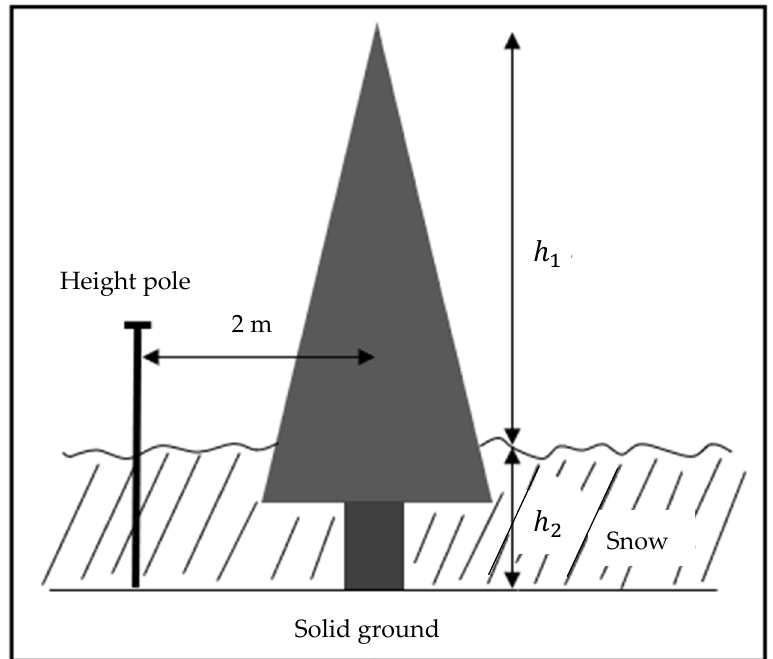
Figure 2. Schematic showing tree height and snow depth measurements. Height h 1 represents tree height measurements above the snow surface measured by a height pole or a vertex clinometer. Height h 2 represents the snow depths measured by a height pole at 2 m distance from the tree stem in the northern, eastern and western cardinal directions. Total tree height was the sum of h 1 and h 2 .